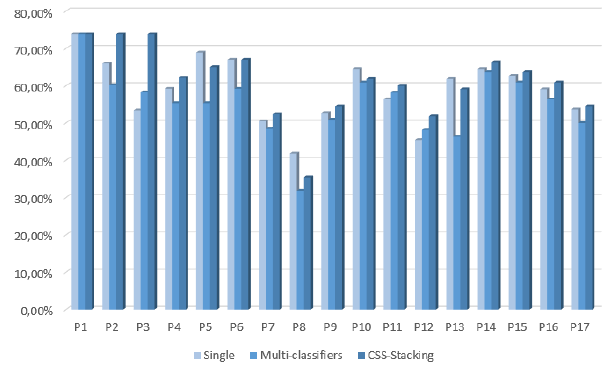
Figure 4. First phase. Best accuracies per person considering single, multi-classifiers and CSS stacking with EDA classification methods.